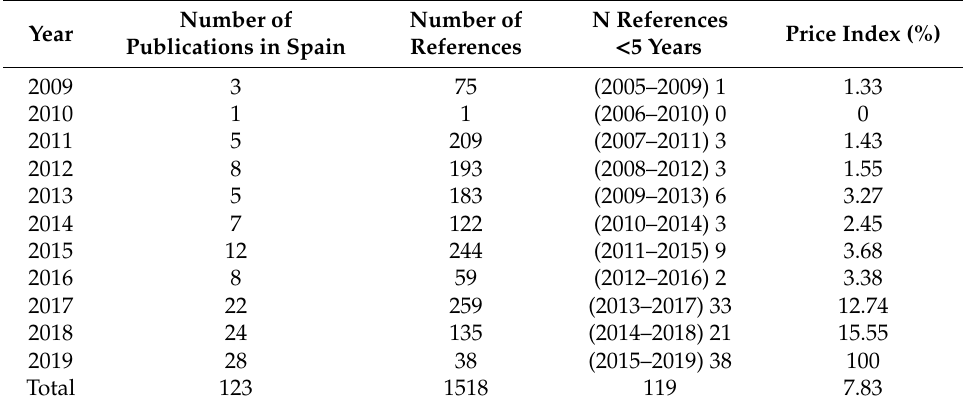
Table 2. Price Index (% of references published less than five years